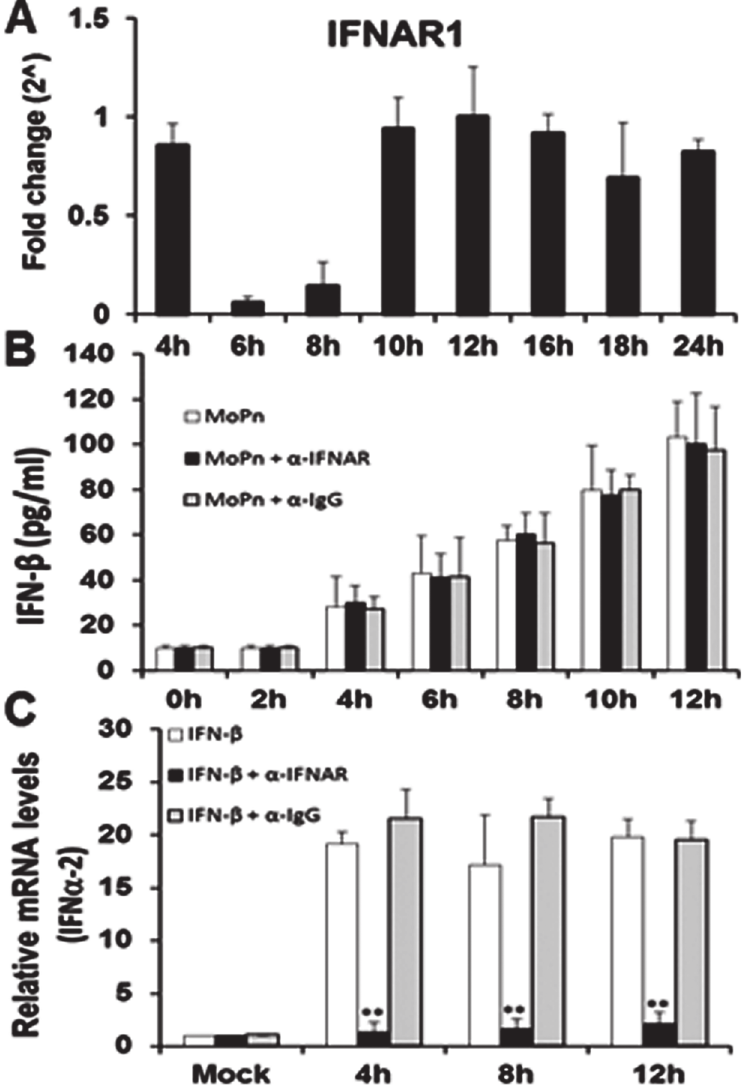
Fig 3. IFNAR1 early gene expression and function during the course of C . muridarum infection. (A) Bm1.11 cells were infected with 10 IFU/ cell C . muridarum and the transcription levels of IFNAR1 was measured by RT-qPCR after total cell mRNA was harvested at each time-point indicated. (B) Bm1.11 cells were infected with 10 IFU/cell C . muridarum in the presence or absence of either the IFNAR1-specific antibody (denoted as α -IFNAR) or the isotype control (denoted as α -IgG) at 1h post-infection, and the amount of IFN- β secreted into the supernatants during the first 12 h of infection was measured by ELISA. (C) Bm1.11 cells were incubated for 1h in media alone or in media containing either the IFNAR1-specific antibody or the isotype control, before adding 50U/ml recombinant murine IFN- β . Total cell mRNA was harvested after cells were exposed to recombinant IFN- β for an additional 12h, and IFN α -2 transcription was measured by RT- qPCR at the time-points listed. The results shown are representative of three independent experiments; Fold change and relative mRNA levels are compared to Mock-infected controls; ** = p < 0 . 01 when compared to cells treated with recombinant IFN- β alone